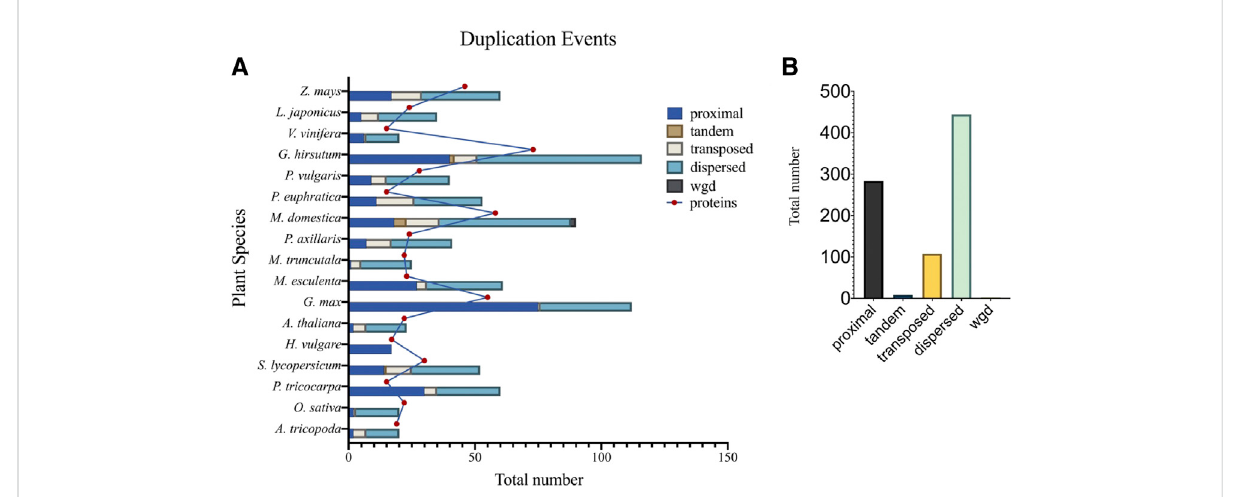
FIGURE 5 Duplication events different plantspecies. (A) Shows thenumberof duplication event types presentinindividualplantspecies, and (B) The